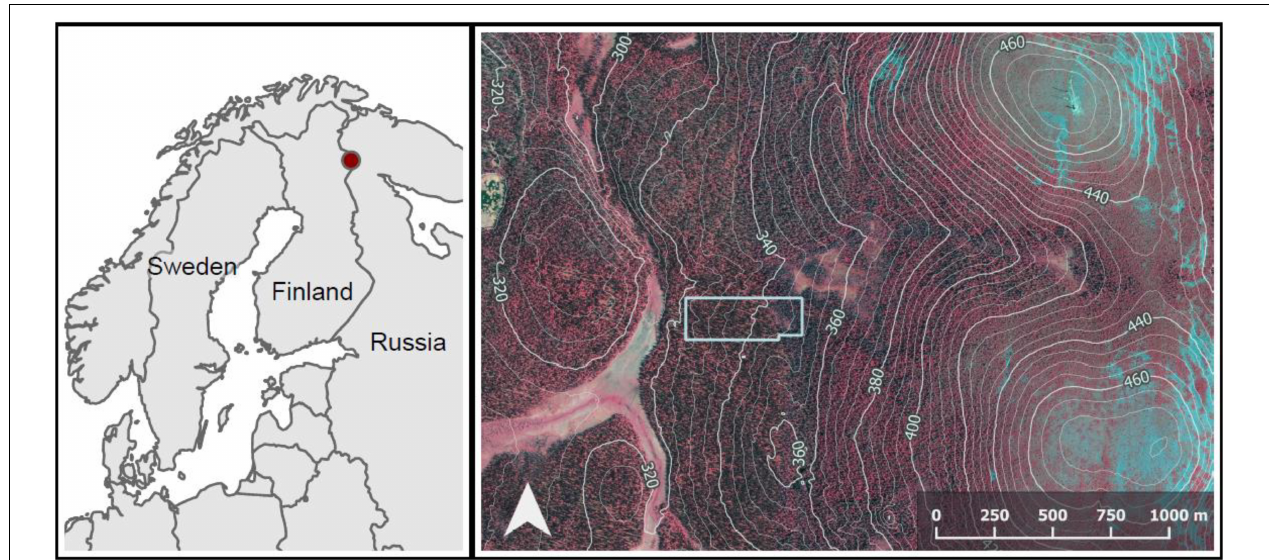
FIGURE 1 | The location of the study plot (polygon in light gray). In the top right corner, the fell Ykkönen, and in the low right corner, the fell Kakkonen. Descending the western slope of Kakkonen, tree species composition changes from Betula pubescens -dominated to Picea abies -dominated in a narrow paludified depression overlapping the east side of the study plot. The depression also includes a small stream area dominated by stunted B. pubescens . The western part of the plot is dominated by P. abies and mixed with B. pubescens. The contours depict elevation above sea level (m). The false-color orthophotograph and the contours were derived from National Land Survey Finland